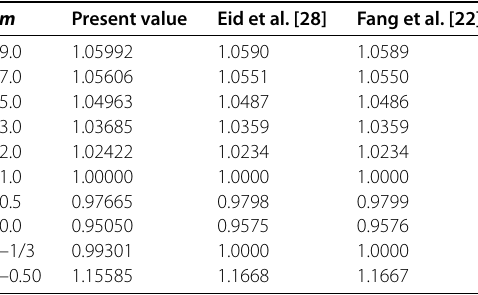
Table 3 Values of – f (cid:2)(cid:2) (0) for different values of m when n = 0.5, We = 0, λ = 0, M = 0, D = 0 and α = 0.5